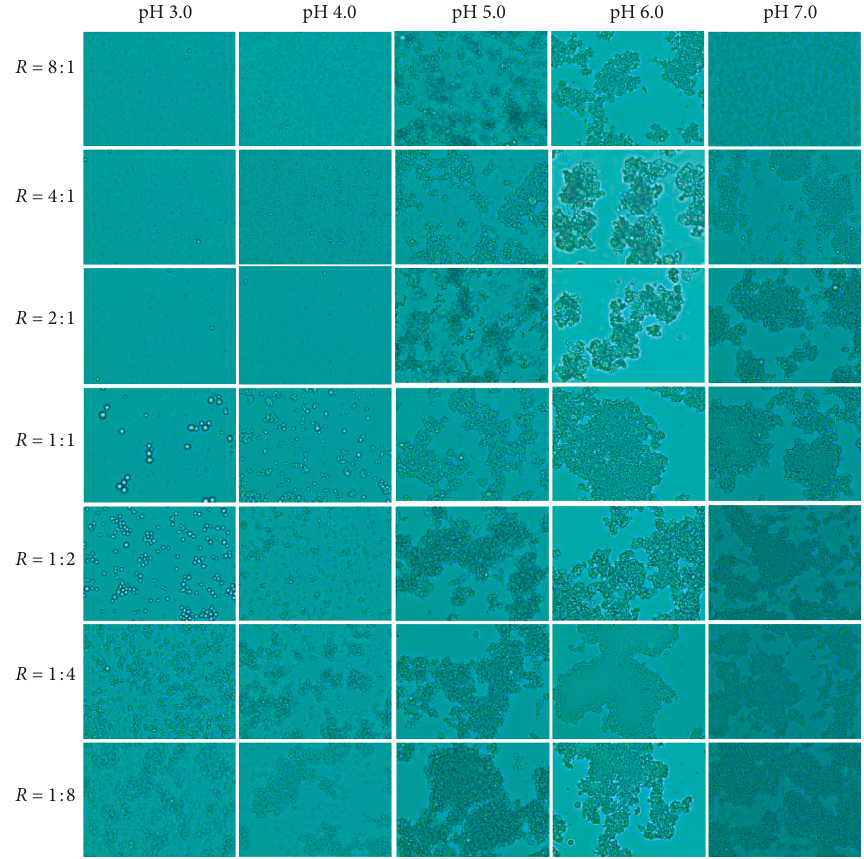
Figure 7: Micrographs with a 400-fold magnification of BSA/WSC emulsions (containing 5% v/v oil) with different pH and different biopolymer ratios ( R � BSA :WSC).